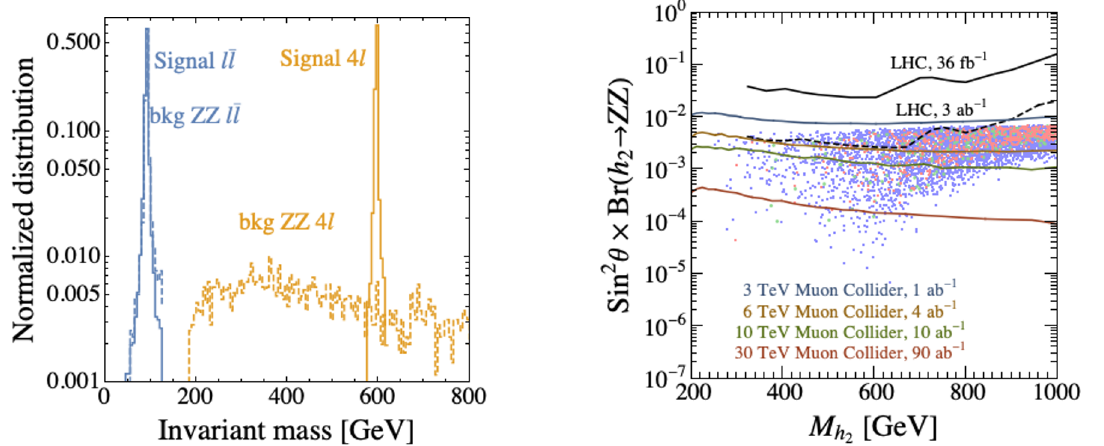
Figure 4 . Left: after the basic acceptance cuts, the invariant mass distributions of the lepton pairs and four-lepton system for the signal and main backgrounds at the 10 TeV muon collider. Here we select M h = 600 GeV as the signal benchmark. Right: the expected probe limits on 2 s 2 × Br ( h 2 → ZZ ) for different muon collider setups. The scatter points are the FOEWPT data, θ in which red, green and blue colors represent SNR ∈ [50 , + ∞ ) , [10 , 50) and [0 , 10) , respectively. The limit from ATLAS at the 13 TeV LHC with L = 36.1 fb − 1 [120] and its extrapolation to the HL-LHC [12] are also shown for